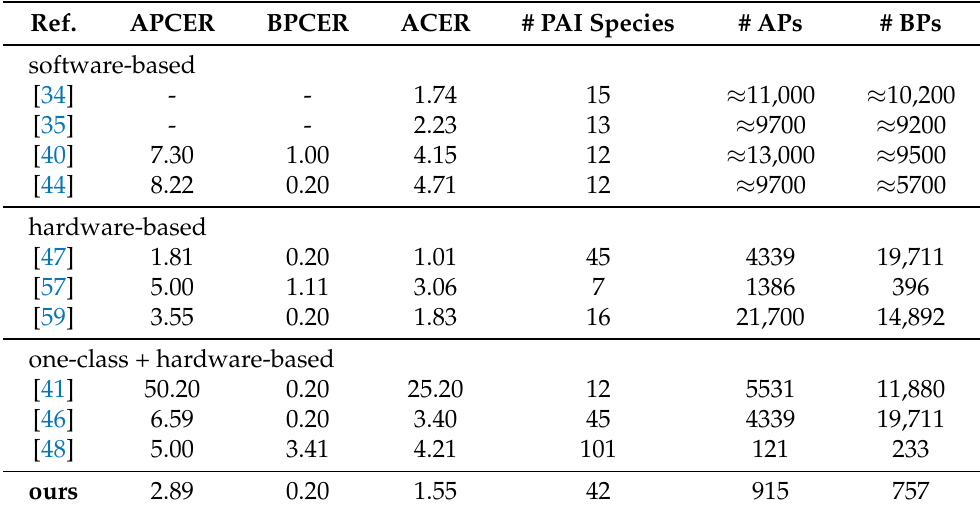
Table 6. Comparison of state-of-the-art with the proposed fingerprint PAD method regarding the main specifications. The error rates are presented in percentages.